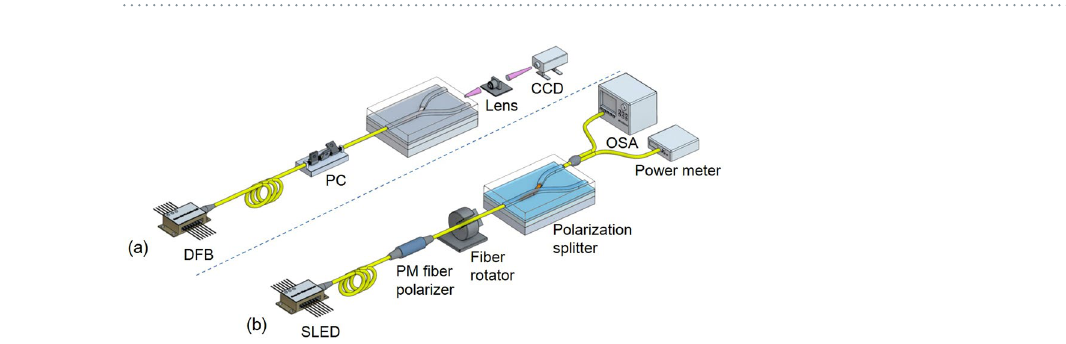
Figure 1. Schematic diagram of the polarization splitter consisting of a taper for extracting TE polarized light, and a Y-branch type CO-polymer waveguide.